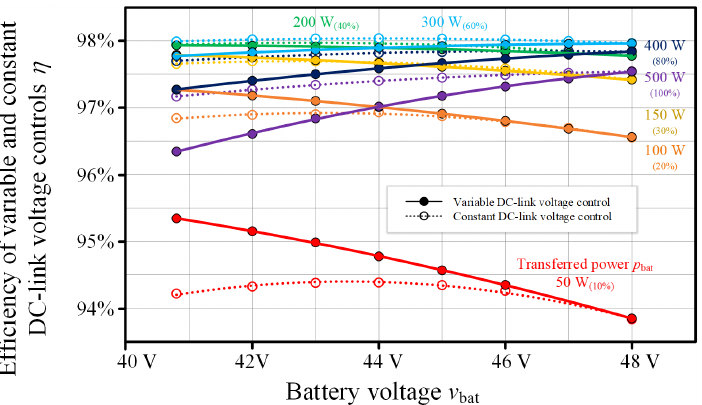
Figure 11. Power conversion efficiency between variable and constant DC-link voltage